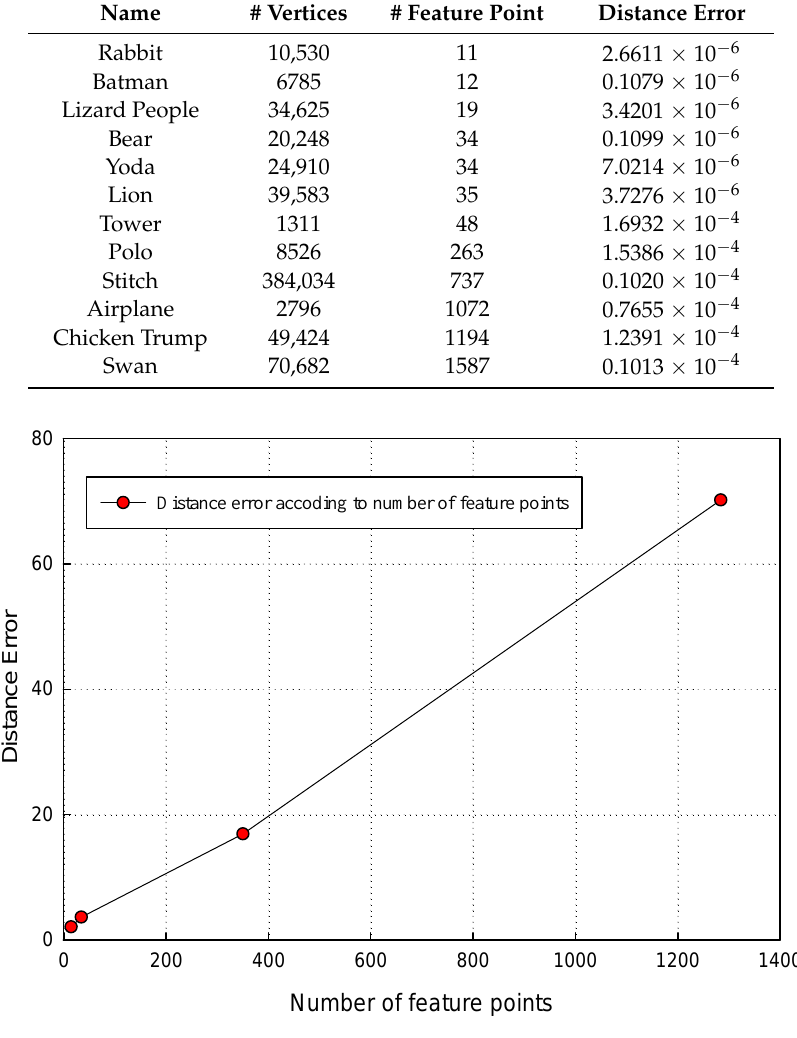
Figure 8. Distance error according to the number of feature points.